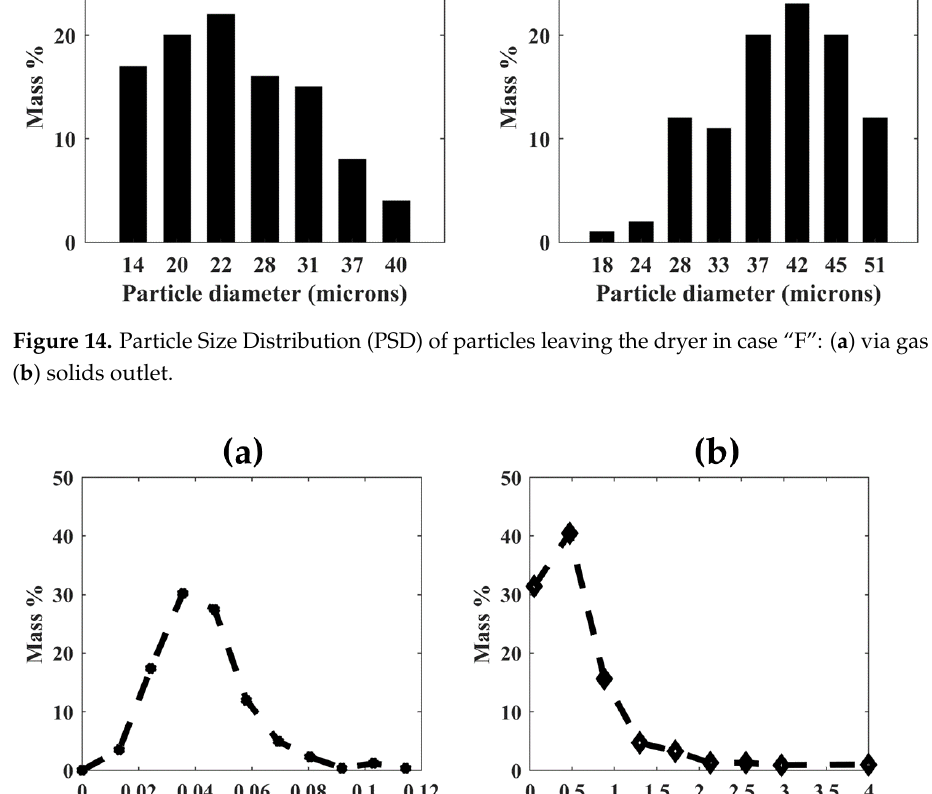
Figure 14. Particle Size Distribution (PSD) of particles leaving the dryer in case “F”: ( a ) via gas outlet; ( b ) solids outlet.